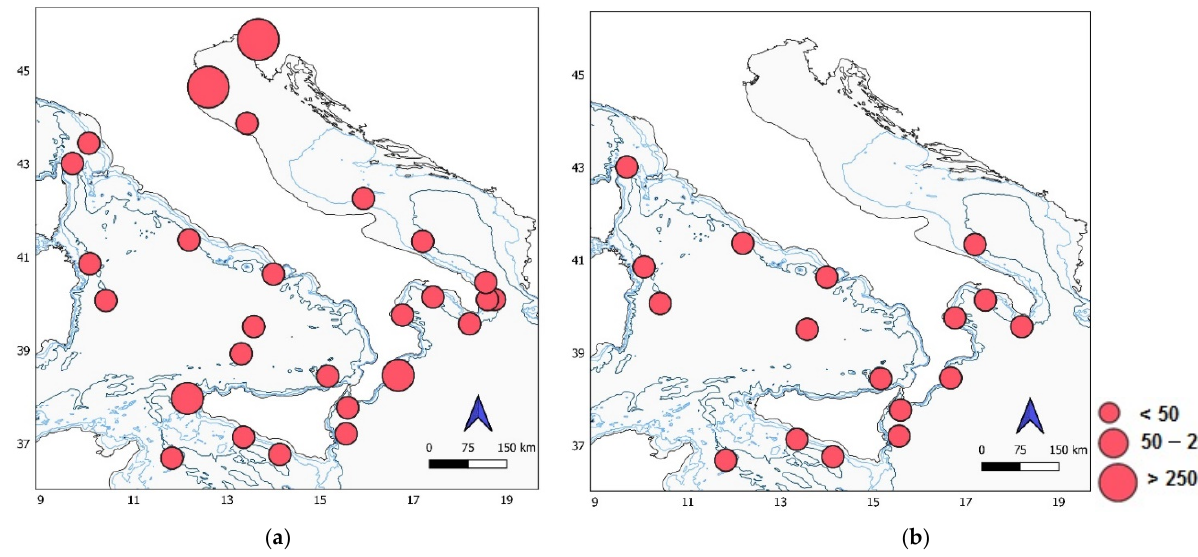
Figure 6 . Total microplankton abundance (ind L −1 ) at ( a ) epipelagic (2–4 m below the sea level), and ( b ) mesopelagic (200– Figure 6. Total microplankton abundance (ind L − 1 ) at ( a ) epipelagic (2–4 m below the sea level), and ( b ) mesopelagic 500 m below the sea level) layers. (200–500 m below the sea level)